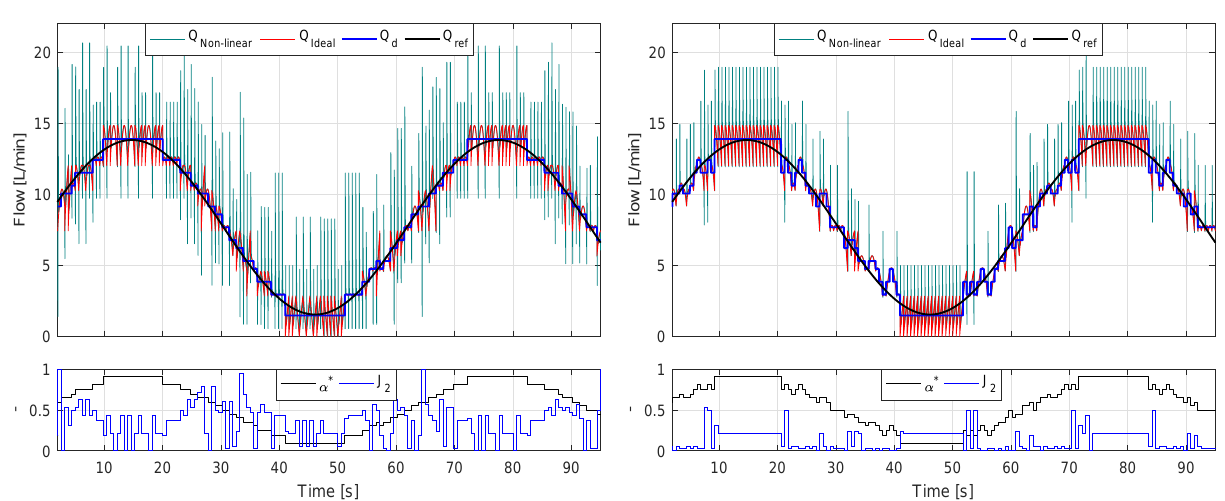
Figure 7: Flow tracking response using the DEA-MPC Figure 8: Flow tracking response using the DEA-MPC algorithm without the energy cost function. algorithm with the energy cost function.